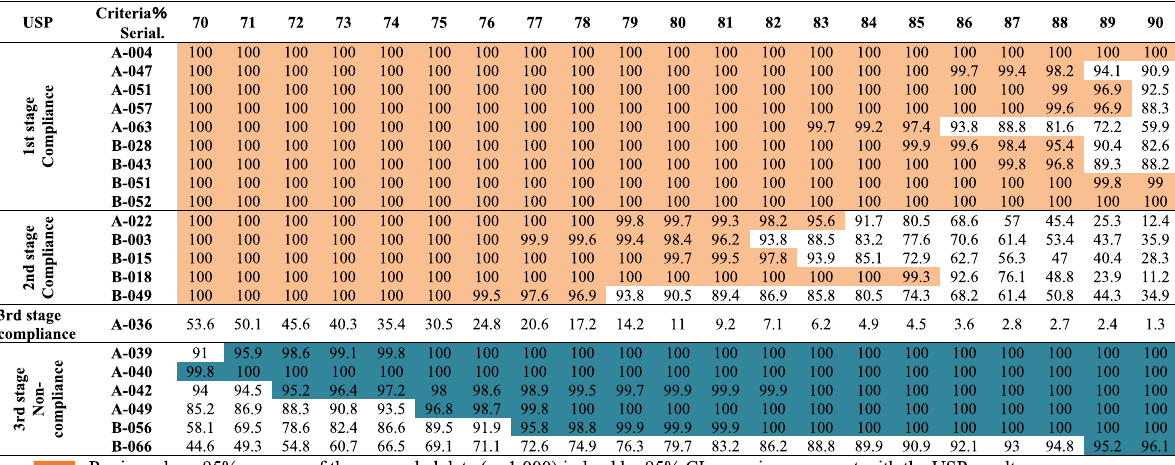
Table 1. Bootstrap sampling distribution for agreement rate with USP when n = 21 samples of metronidazole were judged in terms of the 95% confidence interval lower limit value (95%CI low ) of the average dissolution rate of n = 3